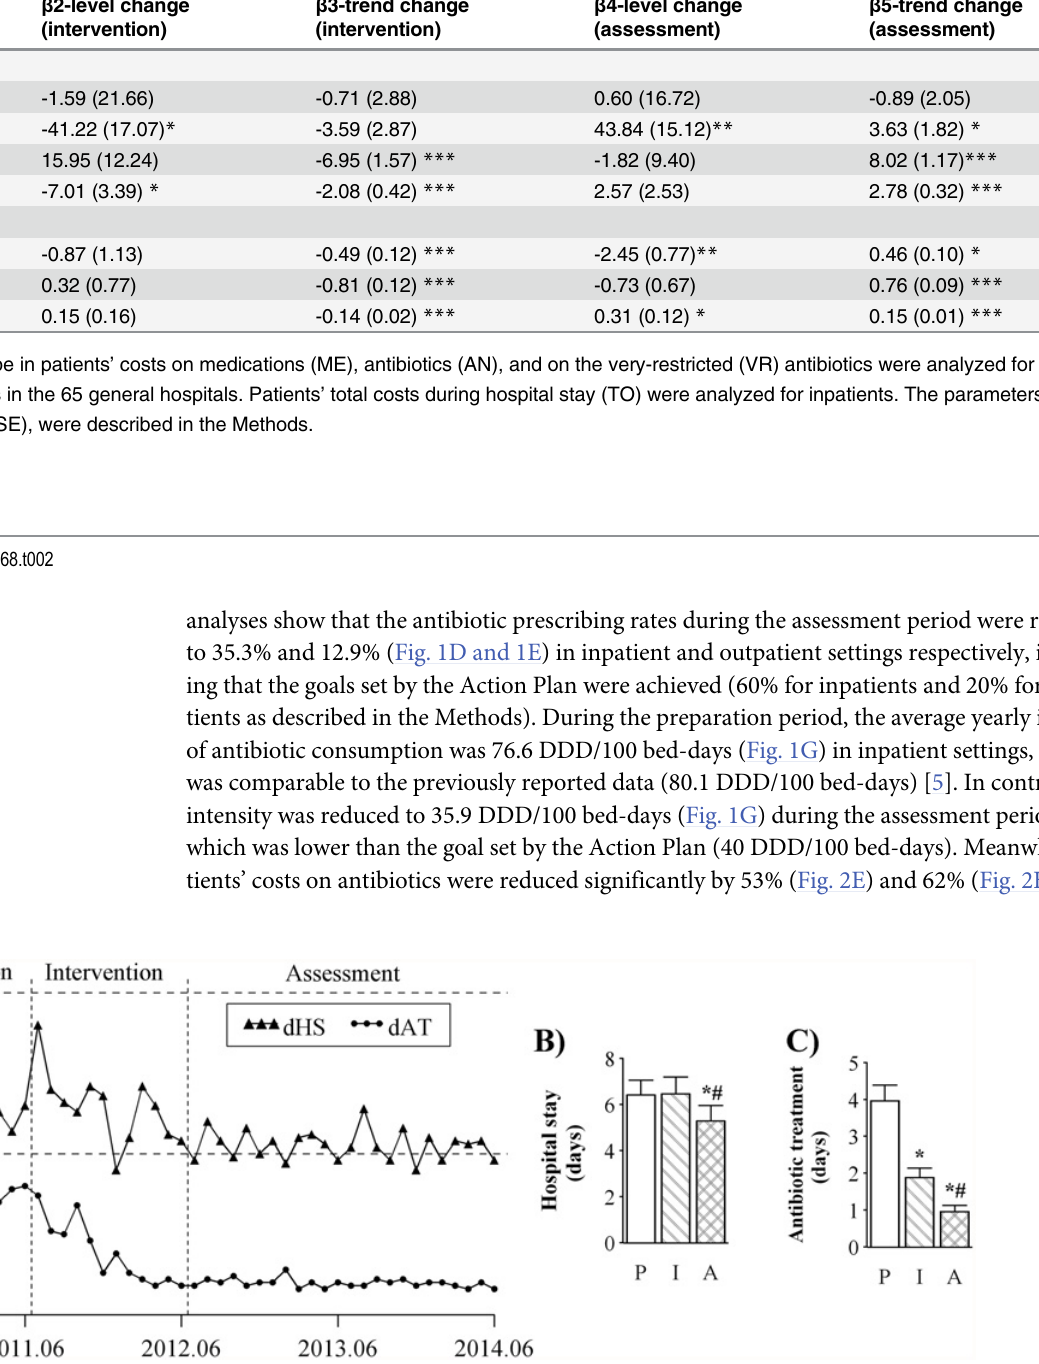
Fig 3. Changes in hospital, duration of peri-operative antibiotic treatment. Time series of duration of hospital stay (dHS) and peri-operative antibiotic treatment (dAT) for patients undergoing 4 types of clean procedures of thyroidectomy, breast, hernia, and orthopedic procedures were plotted (A). Cross- sectional analyses were conducted by comparing the duration of patients ’ hospital stay (B) and the duration of peri-operative antibiotic treatment (C) received by the surgical patients during the 3 study periods. P: preparation; I: intervention; A: assessment; * significant difference in intervention/assessment vs. preparation; # significant difference in assessment vs.